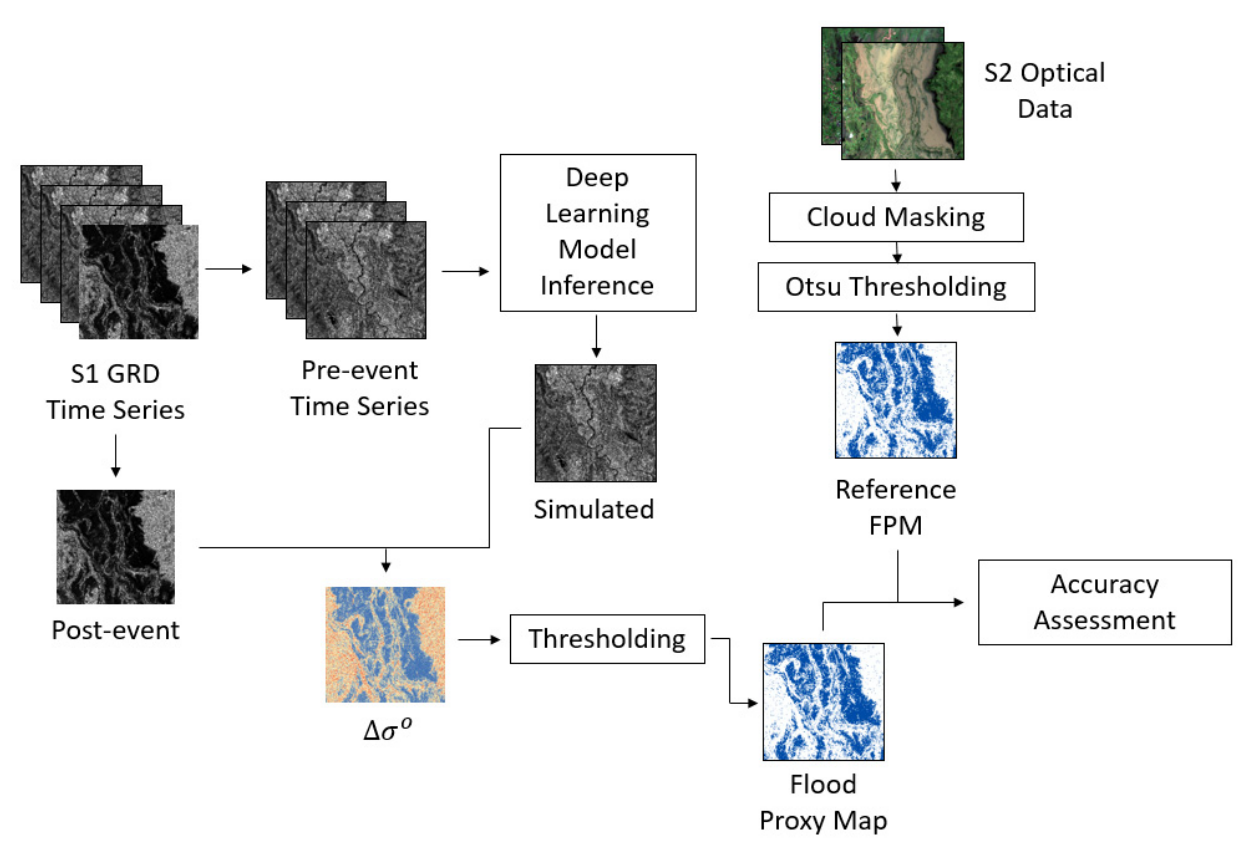
Figure 2. Workflow for the generation of Flood Proxy Maps based on forecasting from RNN LSTM and ConvLSTM models.